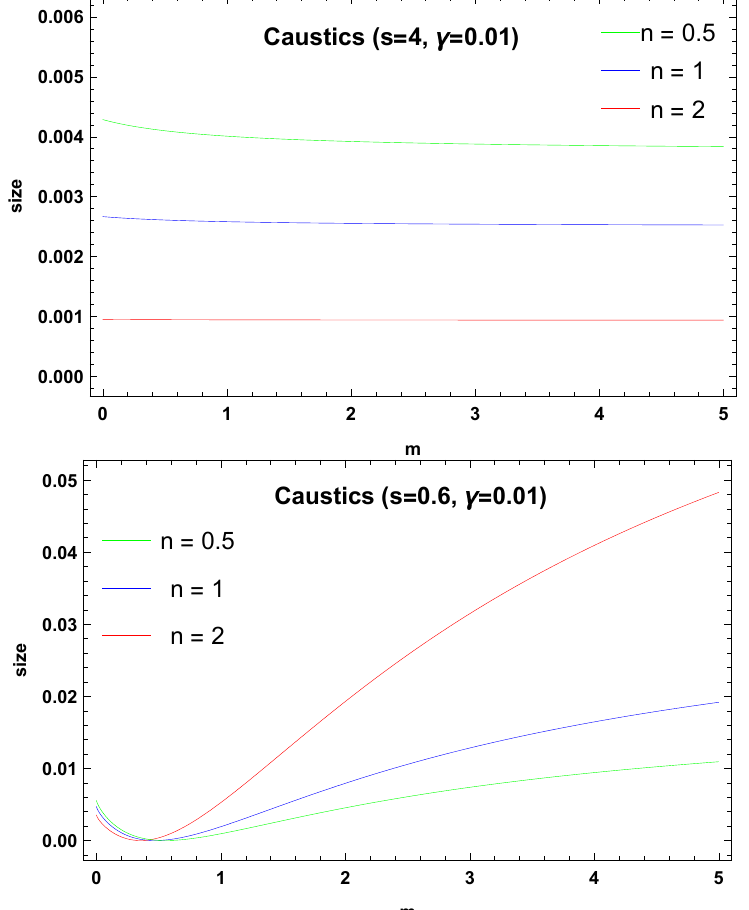
Figure 18. Upper panel: size of the caustic in the wide case for s = 4, γ = 0.01, for three different fixed n = 0.5,1,2, with variable m . Lower panel: size of the caustic in the close case for s = 0.6, γ = 0.01, for three different fixed n = 0.5,1,2, with variable m